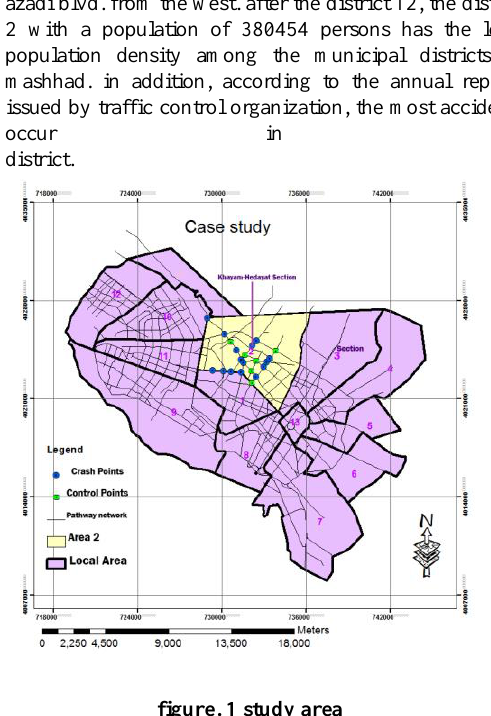
figure. 1 study area